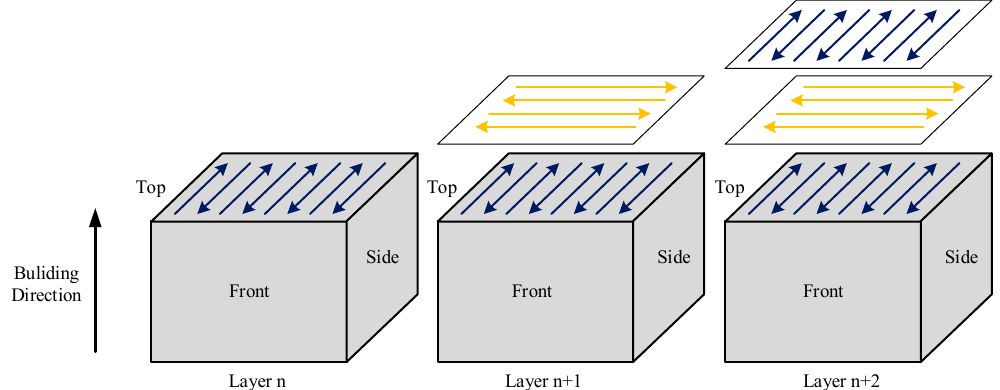
Figure 2. Illustration of the selective laser melting (SLM) process.